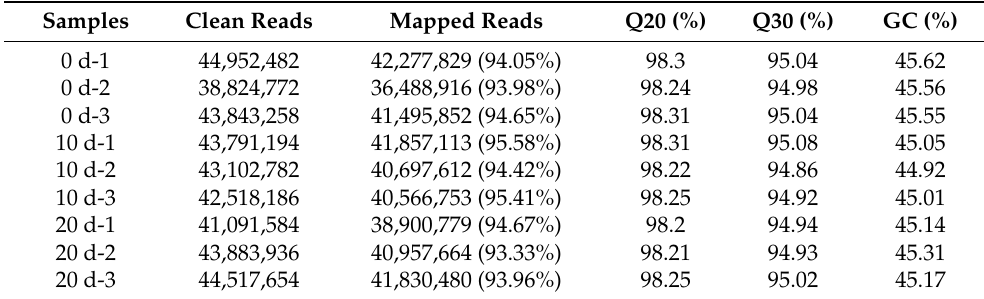
Table 1. Summary of sequence assembly after Illumina sequencing.